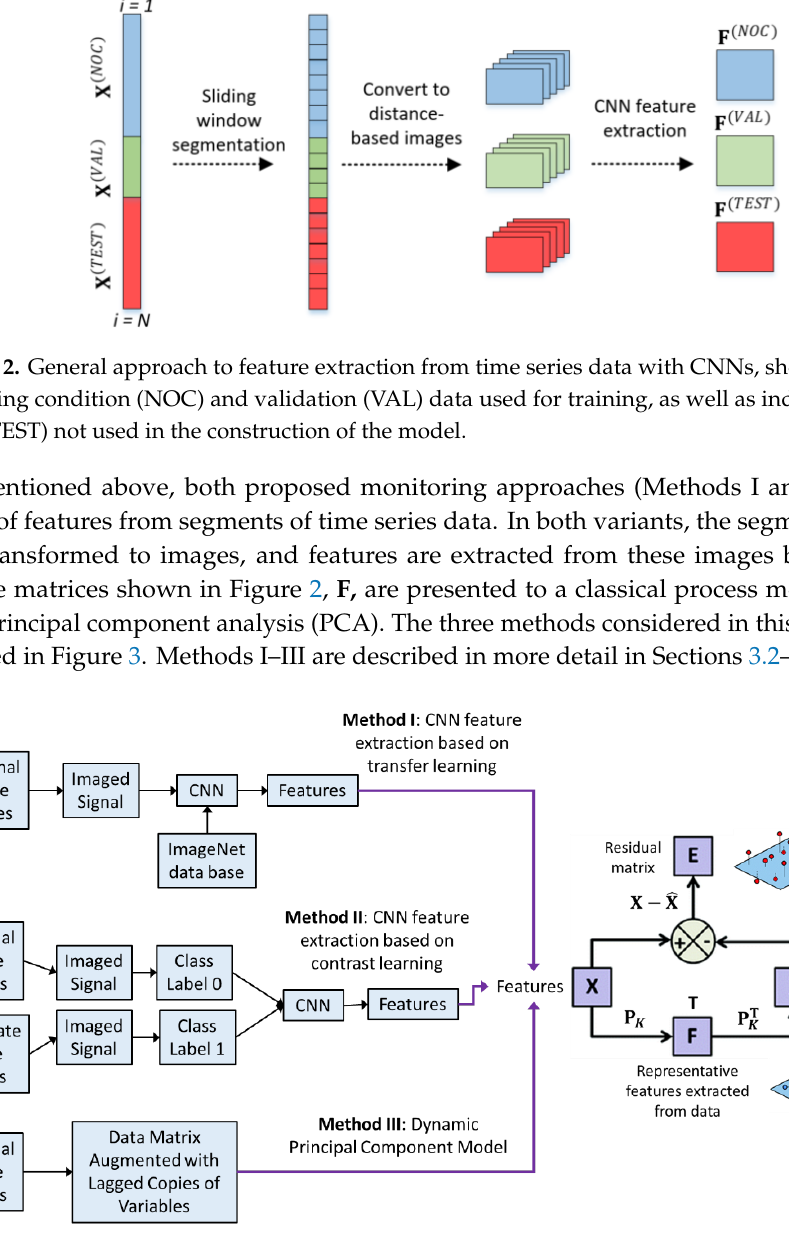
Figure 3. Three approaches to dynamic process monitoring: Method I is based on the use of a principal component model derived from the features extracted from the time series with convolutional neural networks and transfer learning; Method II is the same as Method I, except for extraction of enhanced features; and Method III is based on dynamic principal component analysis.